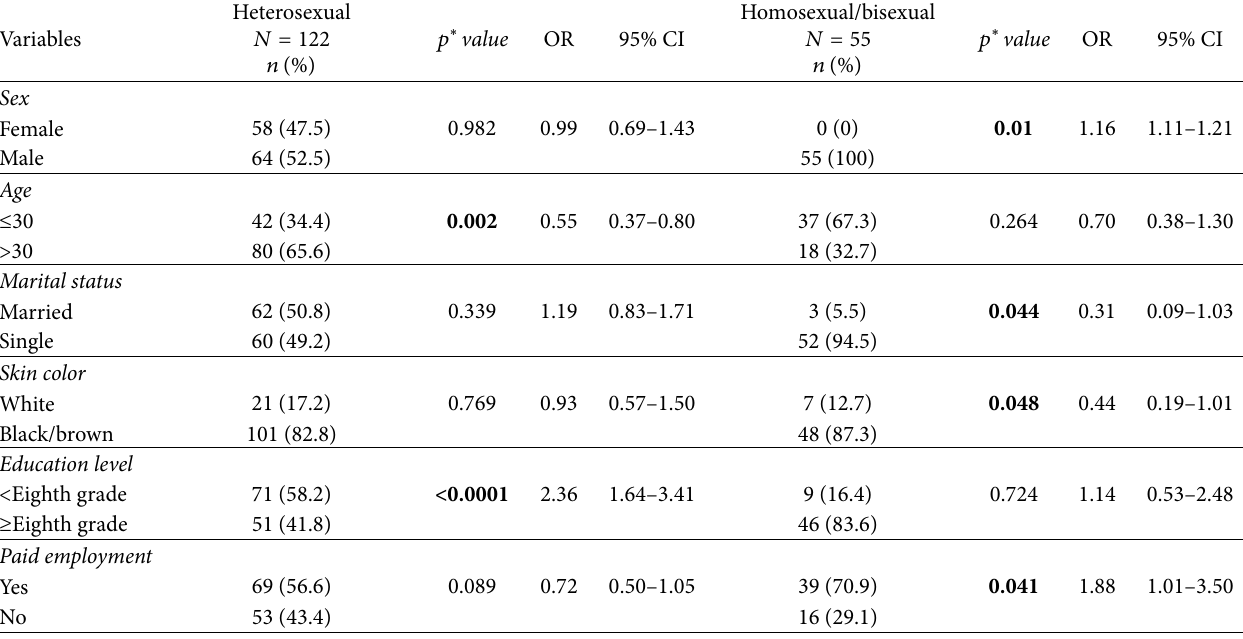
Table 2: List of sociodemographic variables according to the sexual orientation of individuals obtaining HIV-positive results ( 푛 = 177 ).